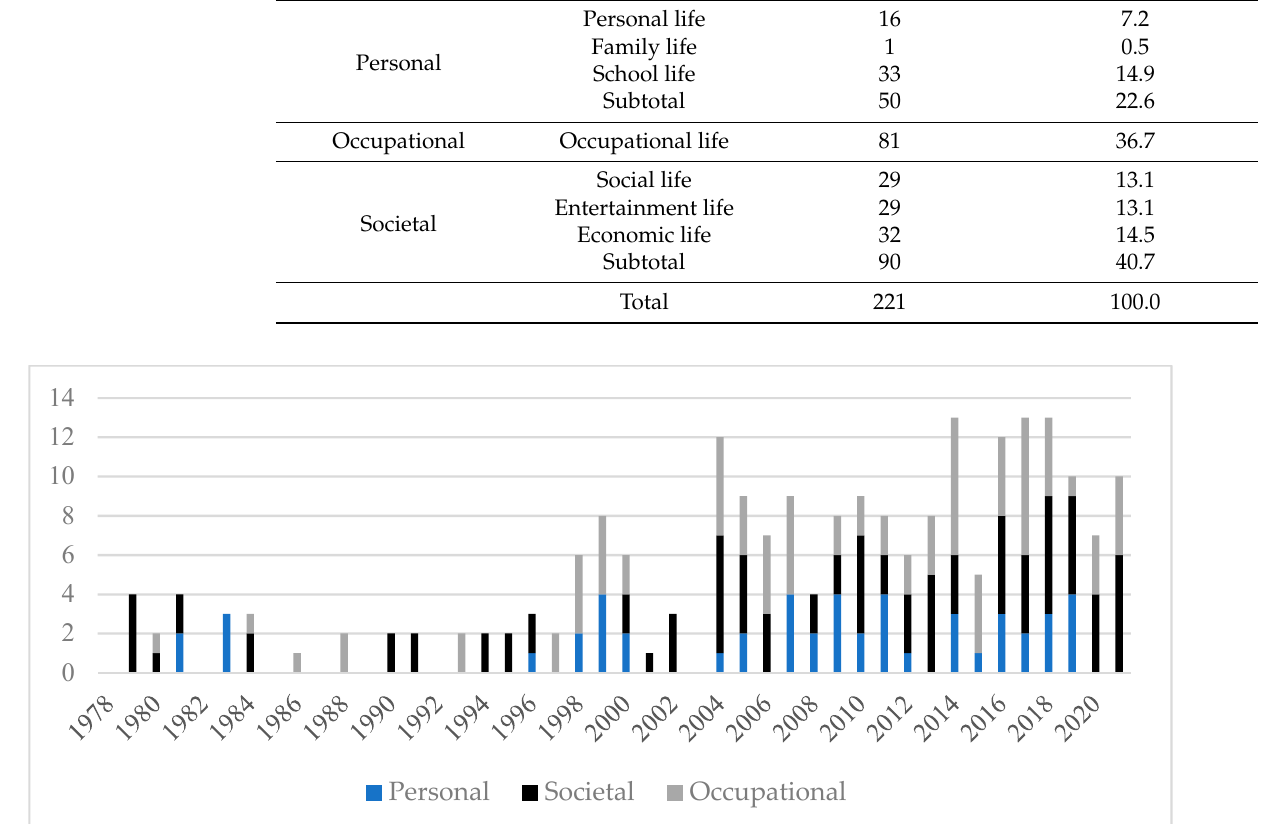
Figure 7. Histogram of the changes in the number of items in different sub-categories of the category of Social Roles .